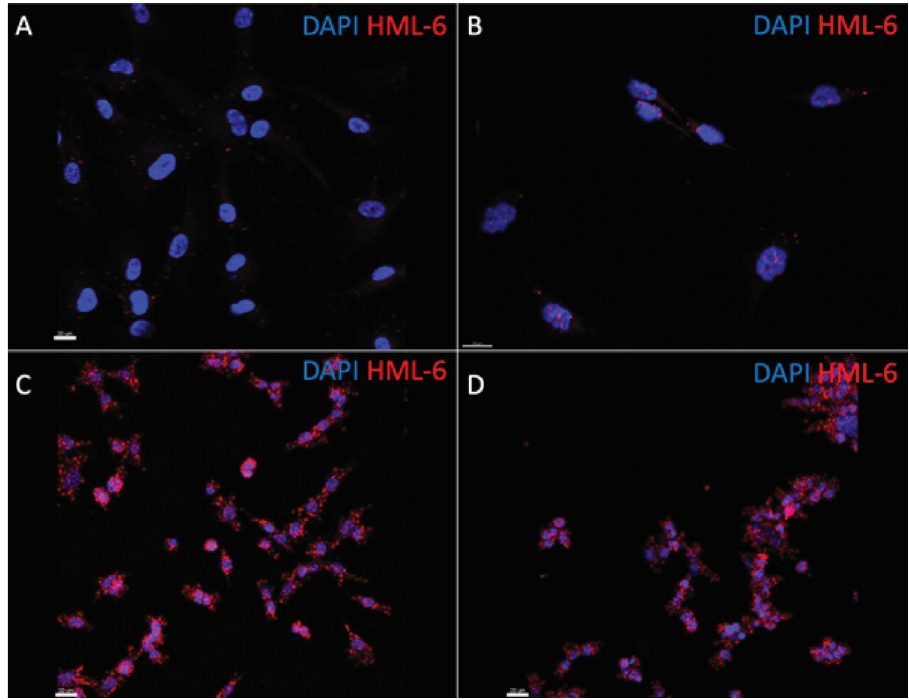
Figure 4. HML-6 is overexpressed in several glioma cell lines compared to astrocytes ( A ). RNA-in situ hybridization confirms presence of HML-6 provirus RNA in the nucleus (DAPI) and cytoplasm of glioblastoma cells. The adherent A172 glioblastoma cell lines ( B ) and neurosphere patient-derived glioblastoma cell lines, GBM28 ( C ) and GBM43 ( D ) have increased levels of HML-6 transcripts compared to